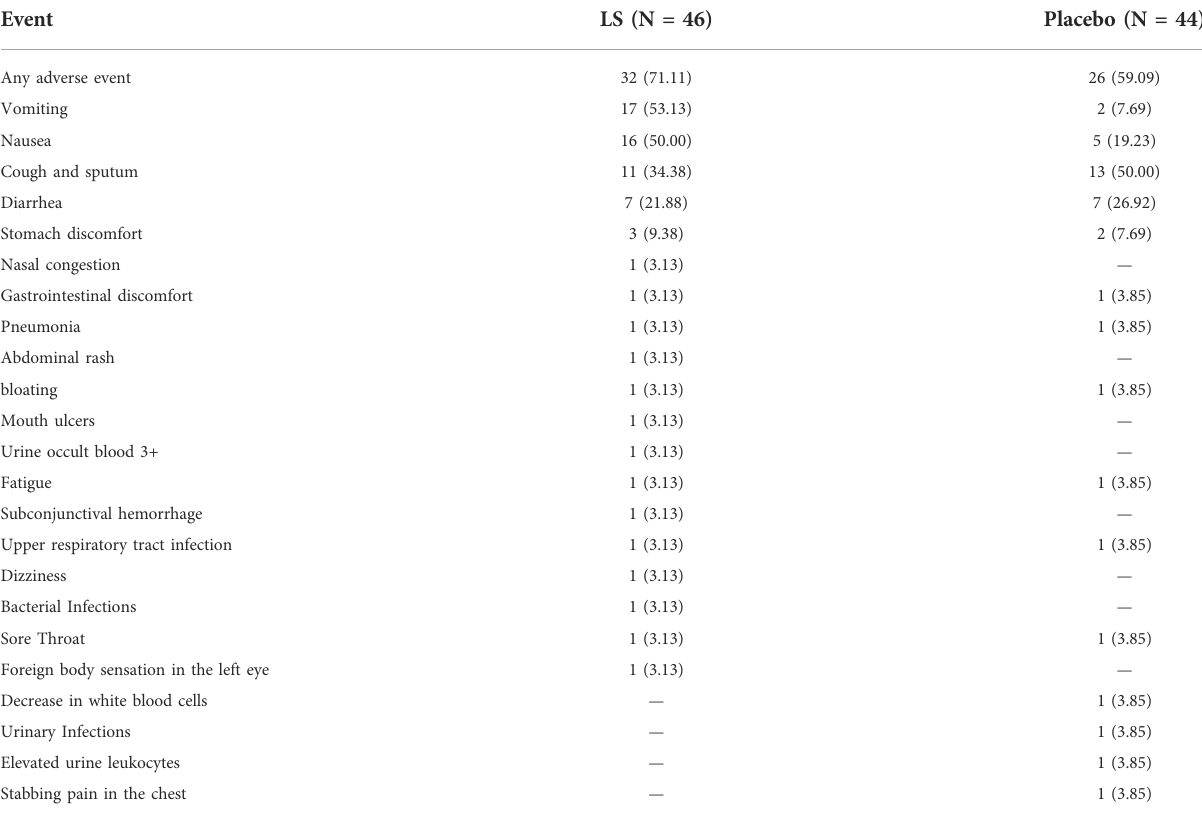
TABLE 7 Adverse events in LS and Placebo group during